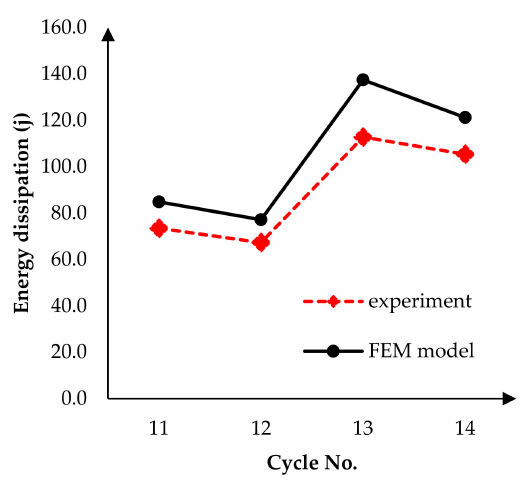
Figure 10. Energy dissipation at the last four cycles.